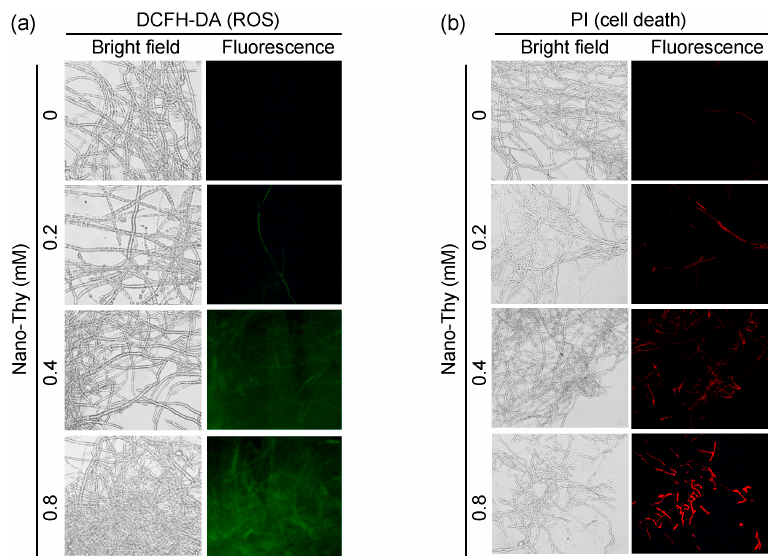
Figure 7. The effect of Nano-Thy on ROS accumulation and cell death in the mycelia of B. cinerea . ( a ) Total ROS indicated by DCFH-DA fluorescence detection; ( b ) cell death indicated by PI fluorescence.